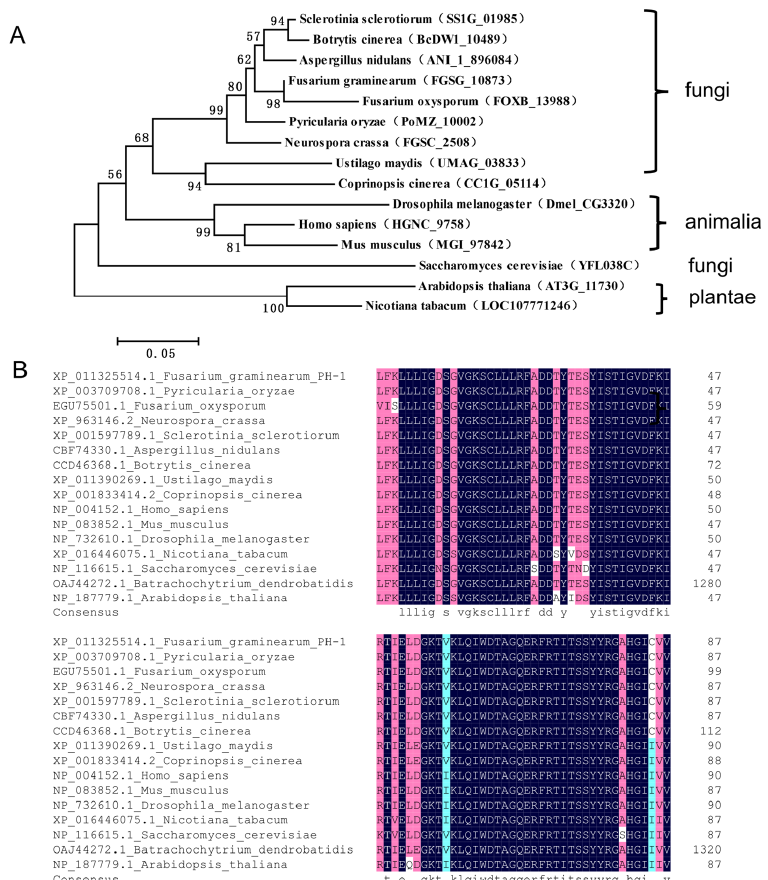
Figure 1. Bioinformatics analysis of Rab1 orthologs. ( A ) Phylogenetic analysis of Rab1 homologs in different species. ( B ) Multiple sequence alignment of Rab1 homologs.